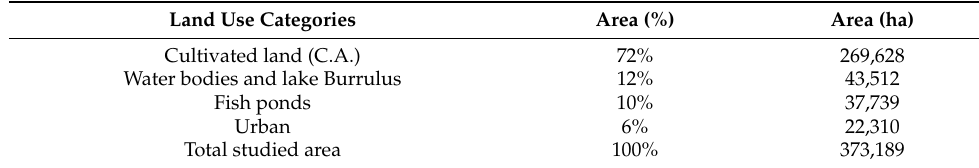
Table 3. The main land use categories in the study area.